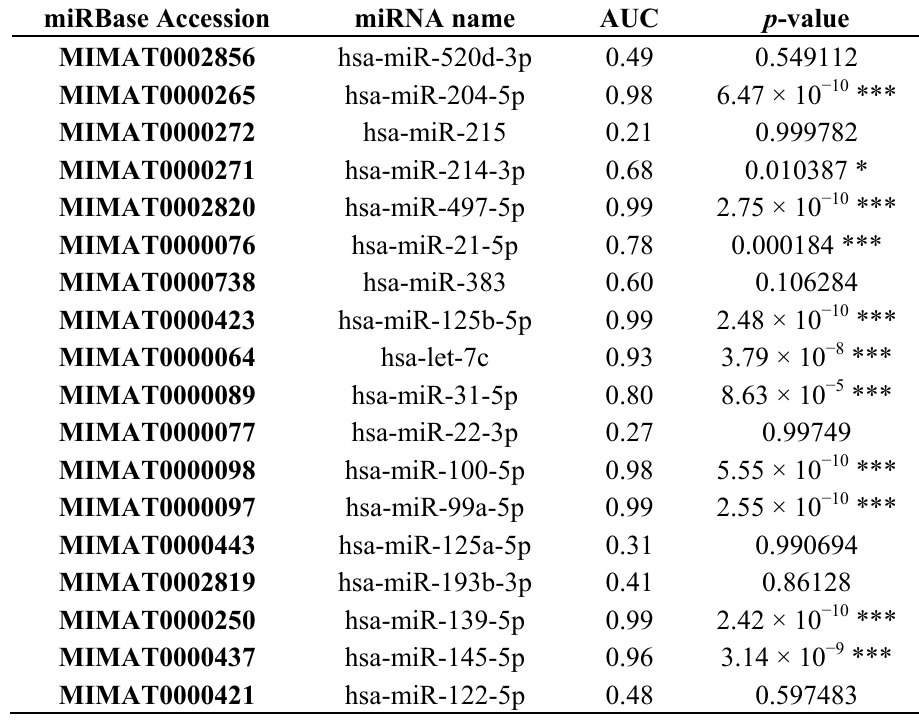
Table S4. Result of ROC curve analysis on our miRNA array data. ROC analysis was done to validate the diagnostic value of the miRNA in the miRNA-regulated PINs. AUC: area under (ROC) curve; * p -value < 0.05; *** p -value <